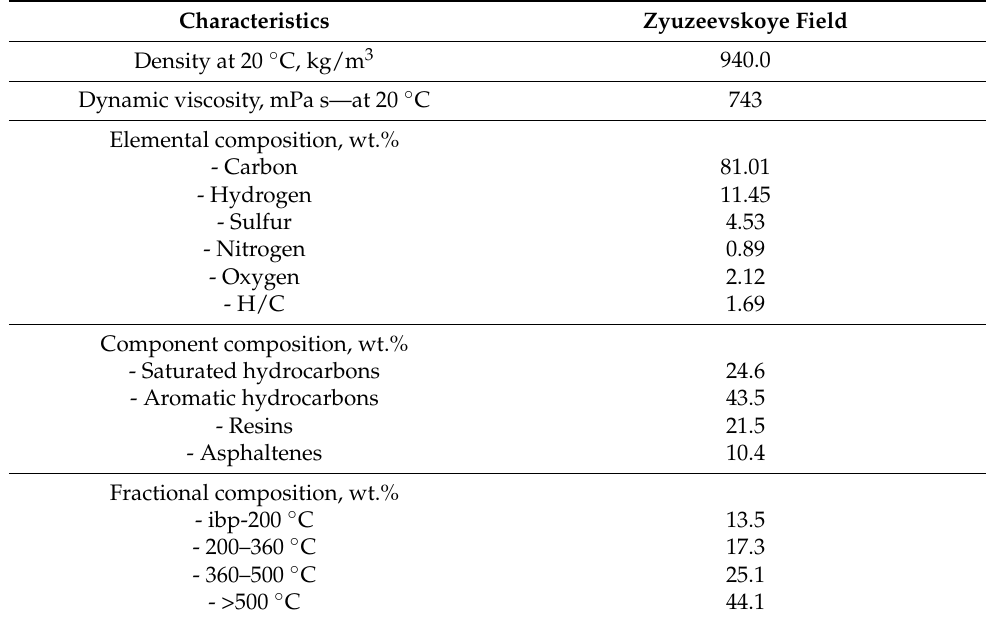
Table 4. Physical and chemical properties of the initial heavy